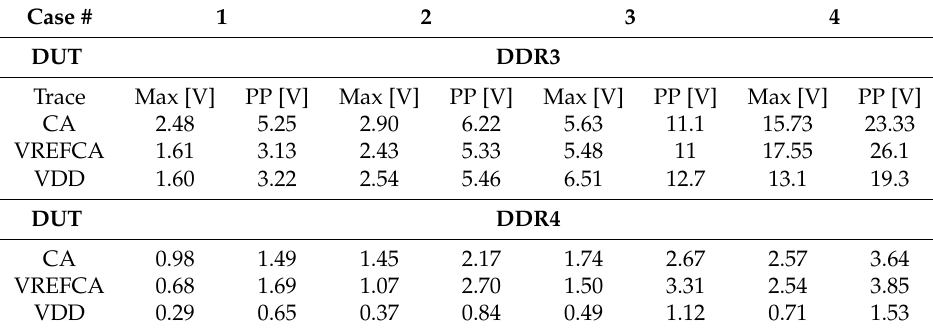
Figure 17. DOE cases results to analyze the effect of number of decaps on induced ESD noises: ( a ) DDR3 module cases; and ( b ) DDR4 module cases. Table 8. Comparison of coupled ESD noise voltages for various DOE cases in Figure 16 (waveform results in Figure